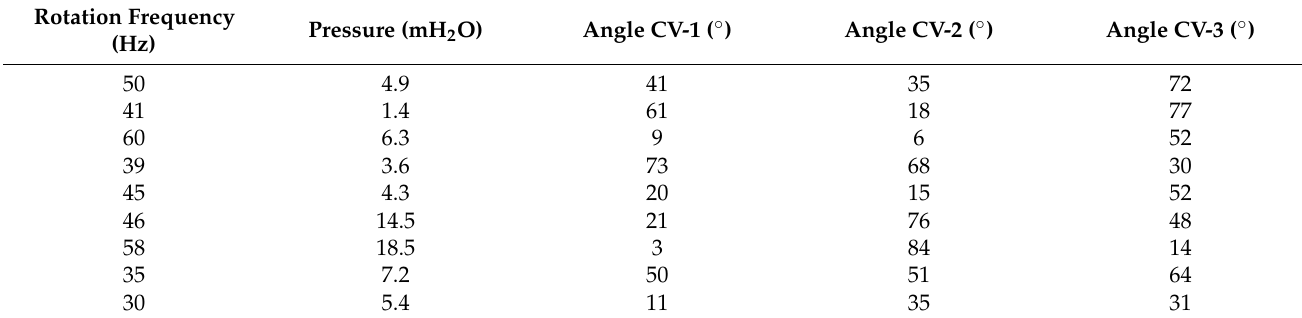
Table 3. Parameters used for the test of the soft sensor validation: testing A.